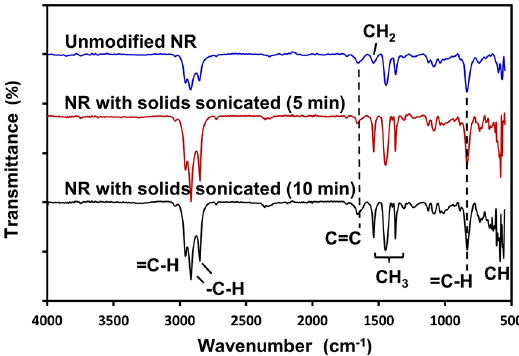
Figure 4. Infrared spectrum with the absorption bands comparison between the films prepared without sonicated solids and after particle size decreasing by sonication.